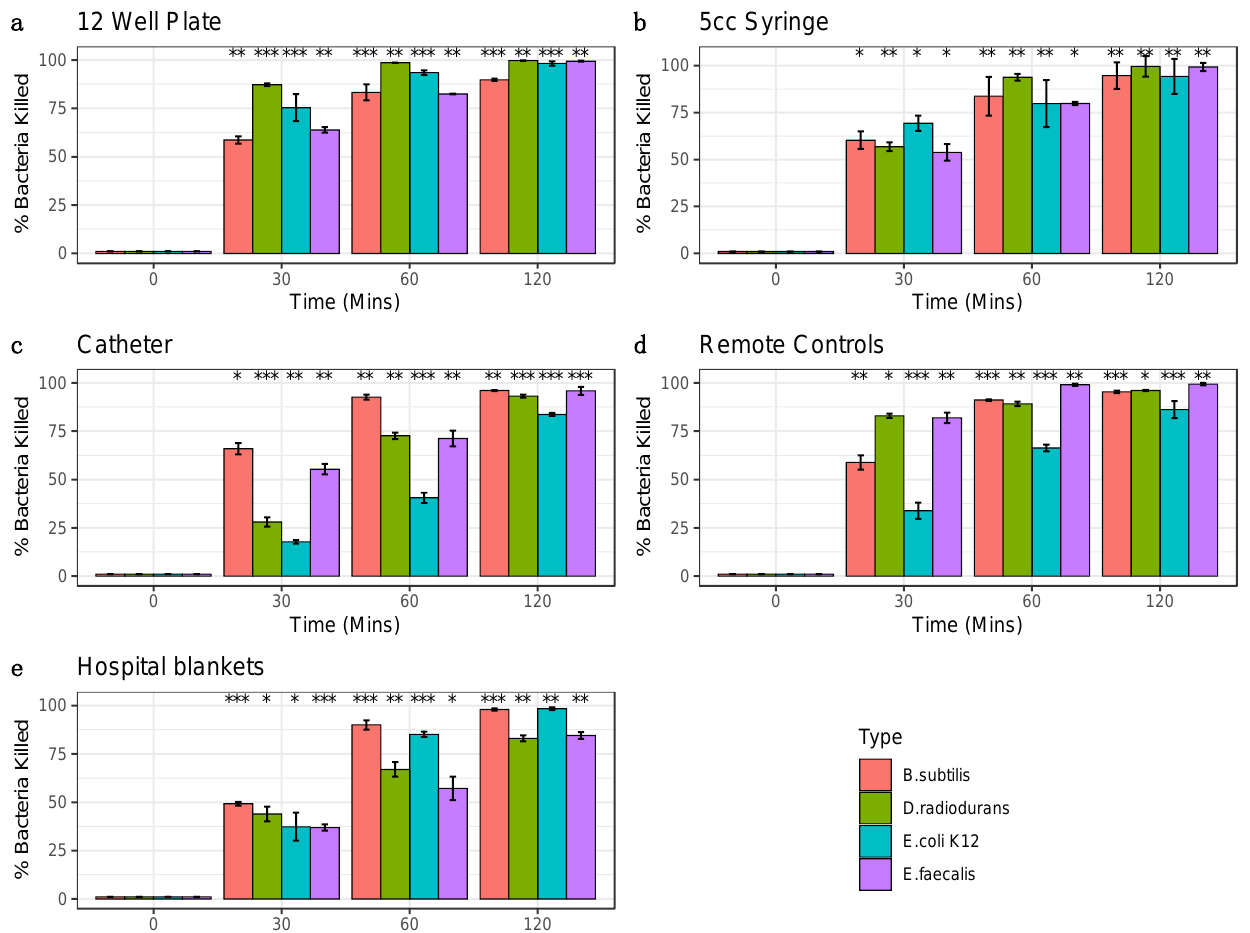
Figure 2. Percent Bacterial Reduction. Bacterial percent reductions for B. subtilis (red), E. coli K12 (green), D. radiodurans (blue), and E. faecalis (purple) from ozone treatment (20 ppm). Error bars represent standard error of the mean from triplicate experiments on a variety of surfaces: ( a ) 12 well plates ( b ) syringes ( c ) catheters, ( d ) remote controls ( e ) hospital blankets. Bacteria species at each time point were compared to corresponding control 0 min (Significance codes 0.001 ***, 0.01 **, 0.05 *, Student’s paired t -test).